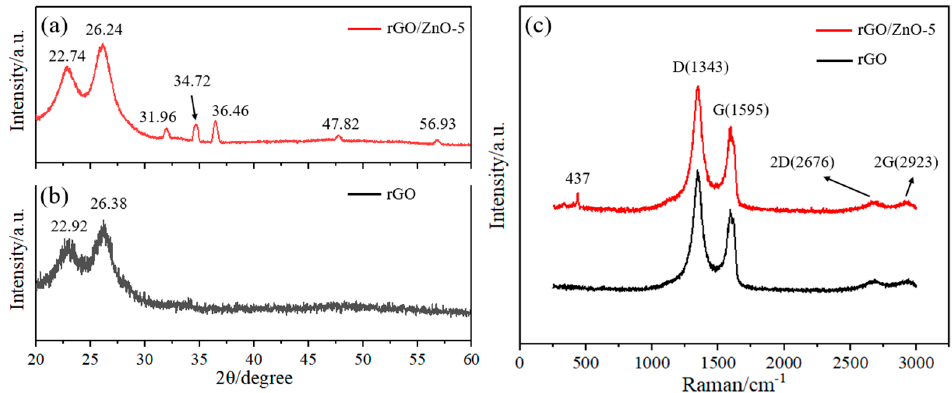
Figure 4. XRD spectra of ( a ) the rGO/ZnO-5 nylon fiber and ( b ) the rGO nylon fiber. ( c ) Raman spectra of rGO and rGO/ZnO-5 nylon fibers.